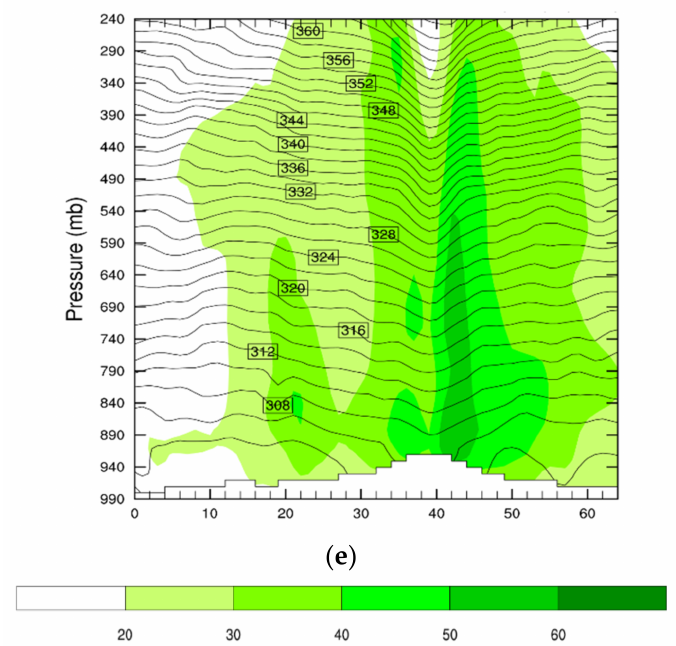
Figure 12. Vertical cross-sections at 23 ◦ N of the horizontal wind speed (shaded; m/s) and potential temperature (5 K, contours) for ( a ) hourly continuous DA (CDA(-3, ( b ) CDA-2, ( c ) CDA-1, ( d ) single time DA (SDA), and ( e ) no DA (NDA) at 0000 UTC 9 August